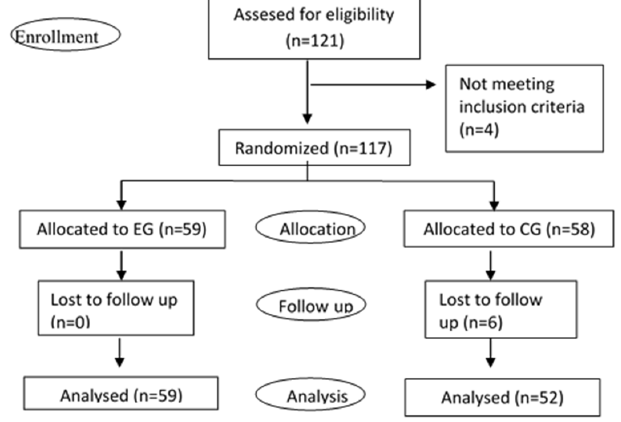
Figure 1. Consort diagram. Note: EG, experimental group; CG, control group.